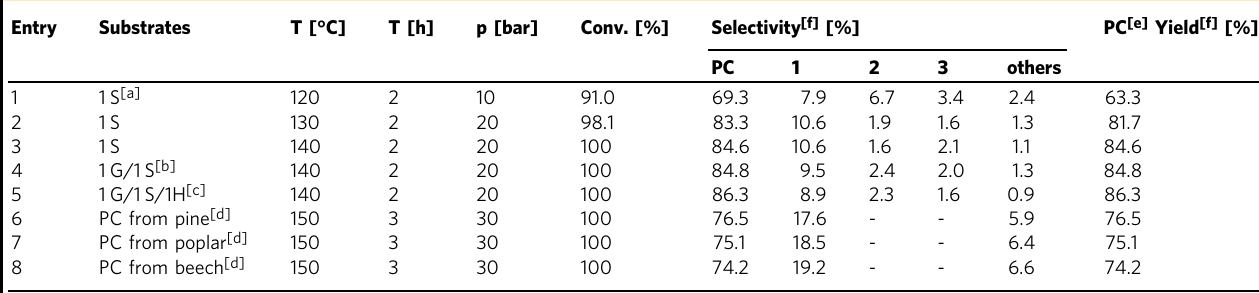
Table 1 Catalytic conversion of model compounds 1 G, 1H, 1 S, and lignin oil to PC diol.